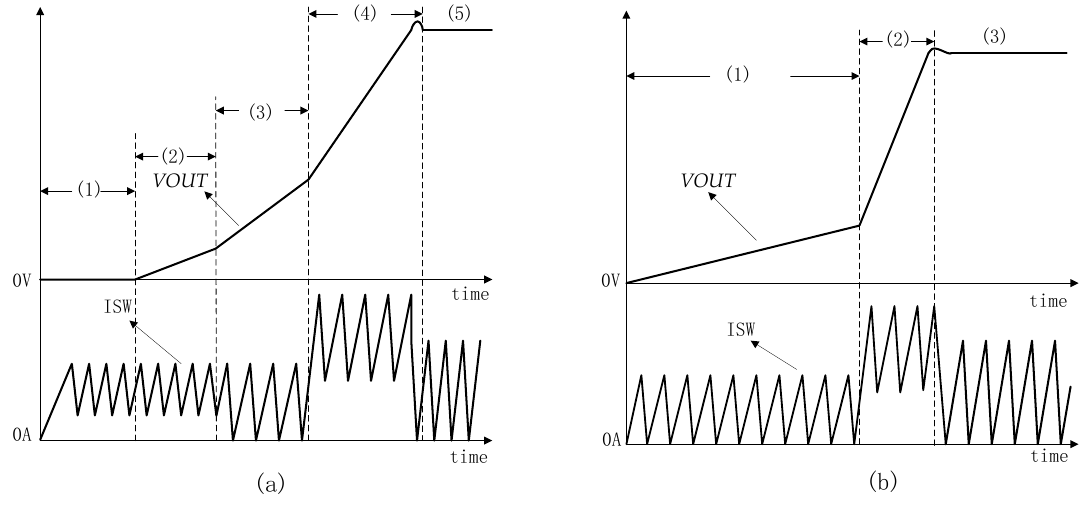
Figure 2. Diagram of the ideal start-up process of the boost converter. ( a ) When VIN ≈ V th . ( b ) When VIN > 2 V th